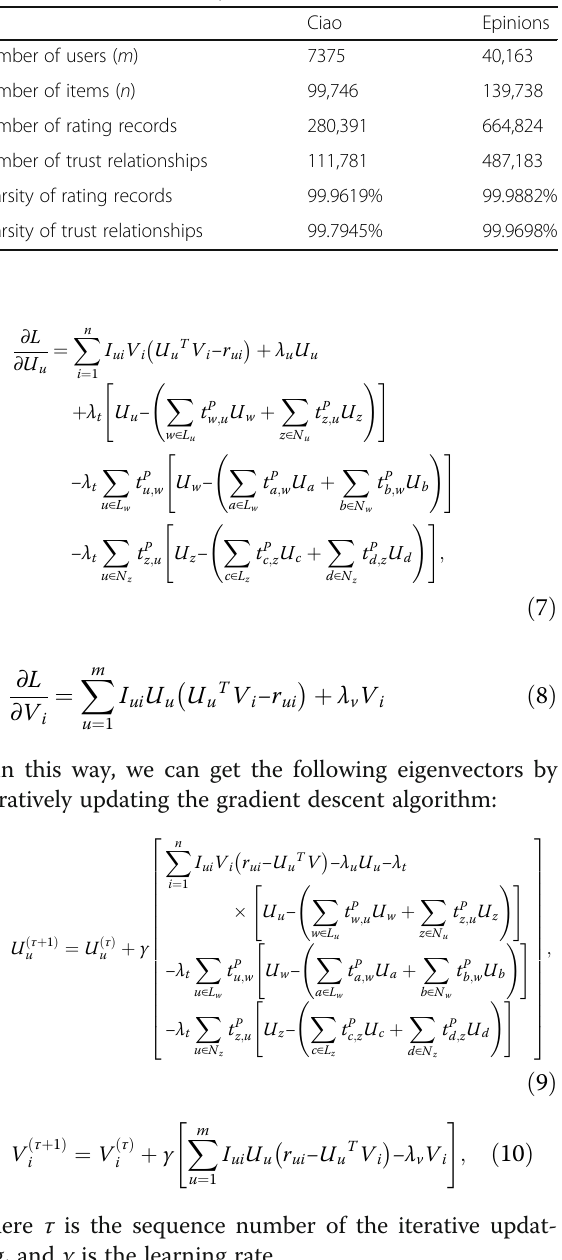
Table 3 Statistics of the experimental